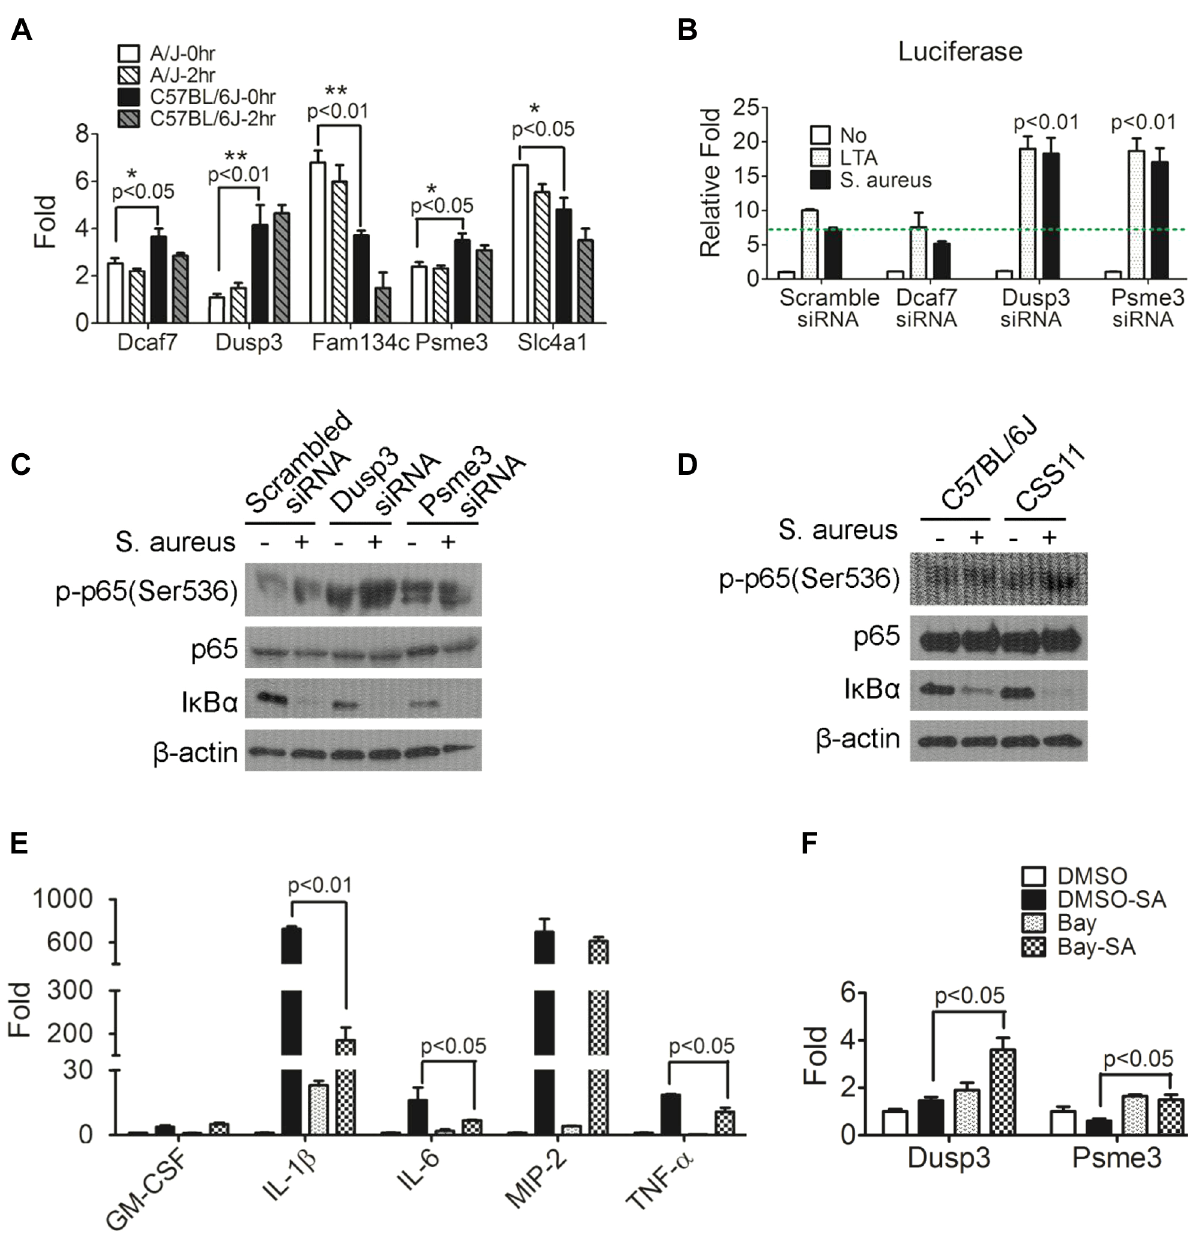
Figure 4. Down-regulation of Dusp3 and Psme3 in A/J are responsible for increased NF- k B signaling activity. ( A ) The expression of Dcaf7 , Dusp3 , and Psme3 in A/J was significantly lower than C57BL/6J under both non-infected and S. aureus infected conditions. Eight-week-old male A/J and C57BL/6J mice (n=6) were challenged (i.p.) by S. aureus Sanger 476 at 10 7 CFU/g or DPBS. At two hours post-infection whole blood RNAs was extracted by RNeasy followed by RT-PCR and qPCR. Dcaf7 (0.81 fold; p , 0.05), Dusp3 (0.27 fold; p , 0.01), and Psme3 (0.83 fold; p , 0.05) were down- regulated in A/J mice at baseline (0 hr) as compared with resistant C57BL/6J. Two genes exhibited elevated expression in susceptible A/J mice (baseline): Fam134c (1.82 fold; p , 0.01) and Slc4a1 (1.31fold; p , 0.05). The baseline difference in expression between susceptible (A/J) and resistant (C57BL/6J) mice of all the five genes remained unchanged at 2 hr post S. aureus -infection. ( B ) Dusp3 and Psme3 inhibit NF- k B signaling activity in RAW264.7 macrophages. RAW264.7 cells co-transfected with NF- k B-luciferase and pRL-TK plasmids were then transfected with siRNA of each individual candidate genes ( Dcaf7 , Dusp3 , Psme3 ) or scrambled siRNA. Then transfected RAW cells were stimulated by either medium alone, medium containing LTA (10 m g/ml) or medium containing S. aureus particles (10 m g/ml) for 7 hours. Cells were directly lysed by 1 6 passive lysis buffer and luciferase activity was assayed and normalized to renilla activity as previously described [15]. As shown, knockdown of both Dusp3 and Psme3 significantly up-regulates NF- k B luciferase activity (p , 0.01). ( C ) Knockdown of Dusp3 or Psme3 enhanced the activation of NF- k B signaling upon S. aureus stimulation. BMDMs from C57BL/6J were transfected with either scrambled, Dusp3 or Psme3 siRNA, then stimulated with S. aureus for 15 minutes. Whole cell lysate was loaded for western-blot. Knockdown of Dusp3 or Psme3 dramatically increased degradation of I k B a and phosphorylation of p65 (Ser536) as compared with scrambled siRNA control. ( D ) Enhanced NF- k B signaling upon S. aureus stimulation in CSS11 BMDMs. BMDMs from either C57BL/6J or CSS11 were stimulated with S. aureus for 15 minutes. Whole cell lysate was loaded for Western blot. BMDMs from CSS11 exhibited increased degradation of I k B a and phosphorylation of p65 (Ser536) as compared with BMDMs from C57BL/6J. ( E ) Bay inhibition of NF- k B dramatically suppressed cytokine production. RAW264.7 macrophages were pre-treated with 4 m M Bay 11-7085 for one hour, then stimulated with 10 m g/ml S. aureus particles in 2 m M Bay for 3 hours. RNA was extracted and subjected to reverse-transcription PCR and